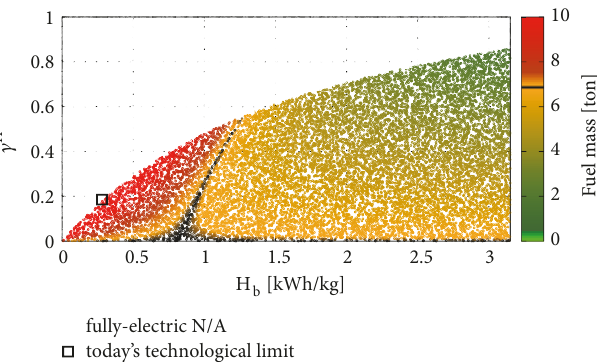
Figure 10: Parametric analysis of fuel mass consumption as function of degree of hybridisation and battery specific energy technology in comparison with iso-fuel solutions (black area) for the configuration characterised by mission requirements of 200-pax and a range of 1800 nmi.